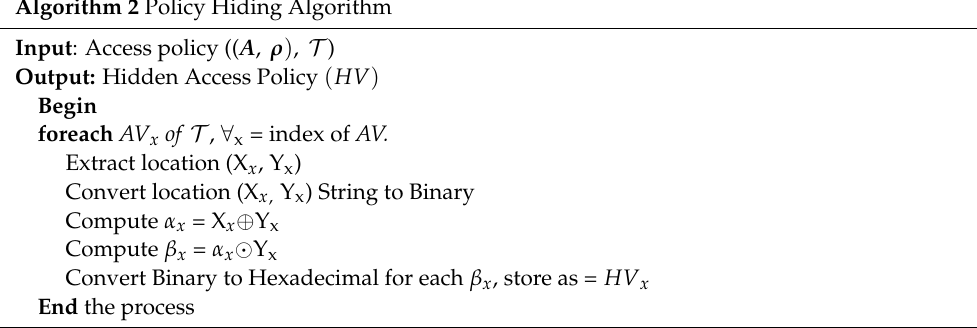
Algorithm 2 Policy Hiding Algorithm